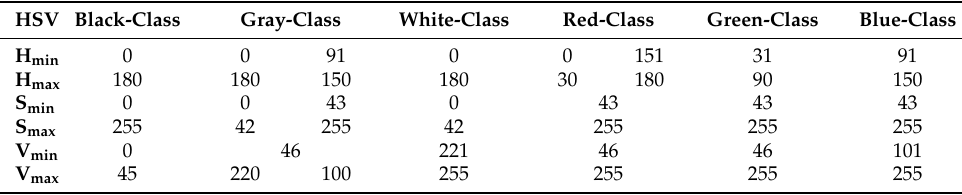
Table A1. Threshold value of H, S, and V in color